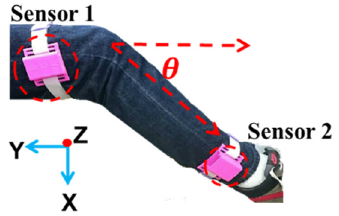
Figure 9. Equivalent angle of knee motion.